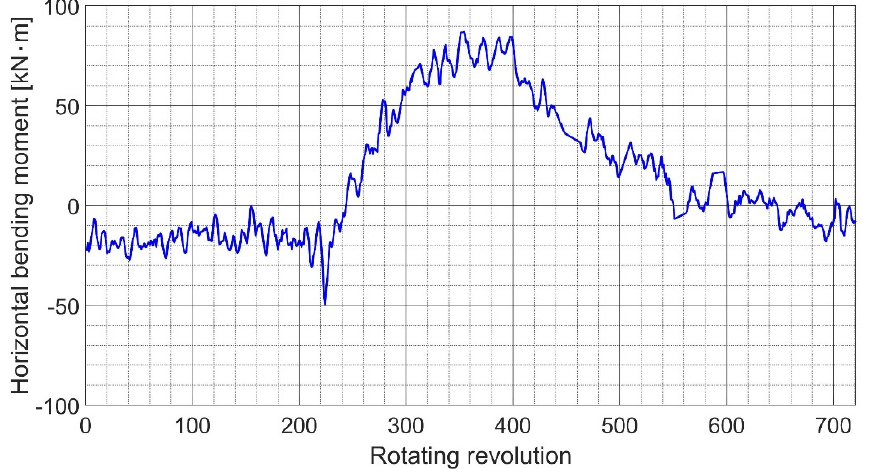
Figure 15. Bending moment in the horizontal direction during the starboard turn under the fully laden condition. laden